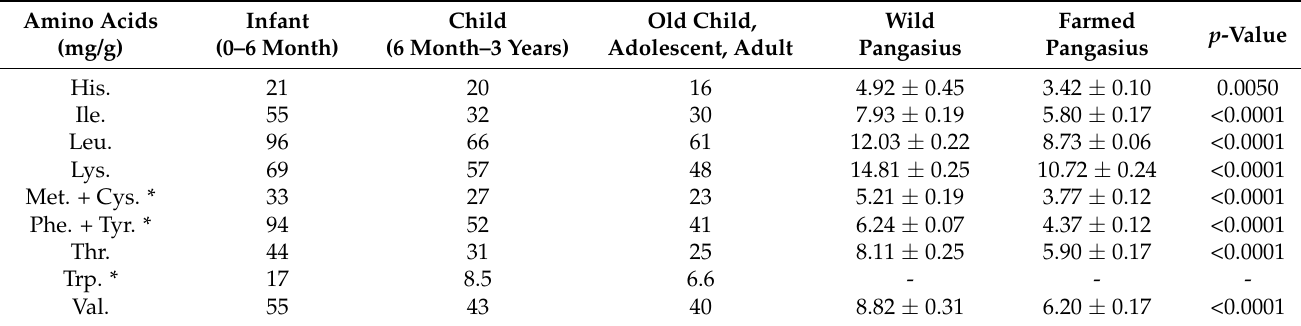
Table 3. Comparison of wild and farmed pangasius catfish amino acid contents mg/g to the amino acid requirements of infants and children of different age groups, based on FAO (2013) standard.